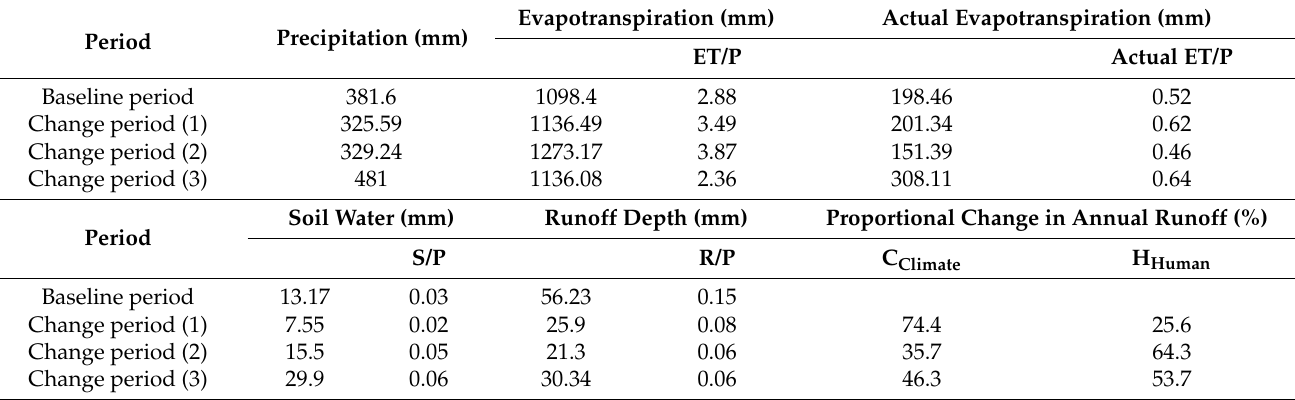
Table 9. Estimated changes in runoff based on the GBHM due to climate variability and land-use changes in the Chabagou River